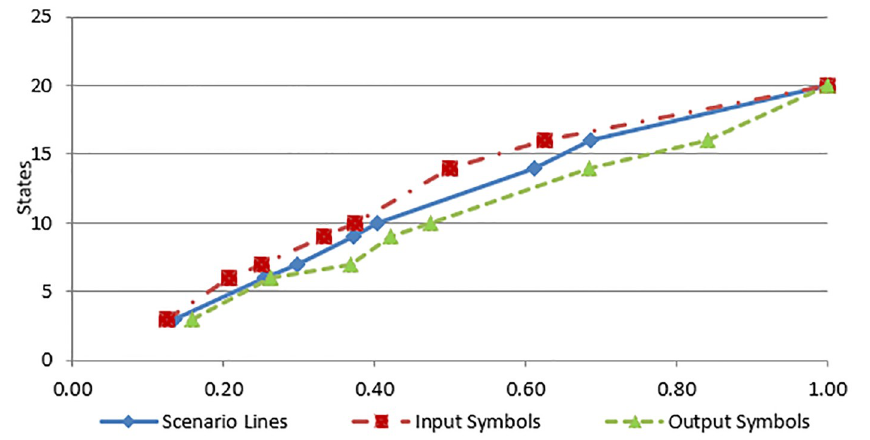
Fig 14. Kripke structure states to use case parameters.